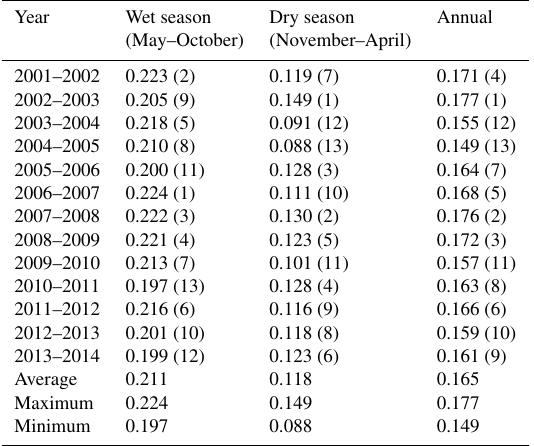
Table 4. Average NDII values during the wet season, the dry season, and the whole year from 2001 to 2013, and their order of moisture content (range is 1–13; lower values indicate less NDII) for the en- tire